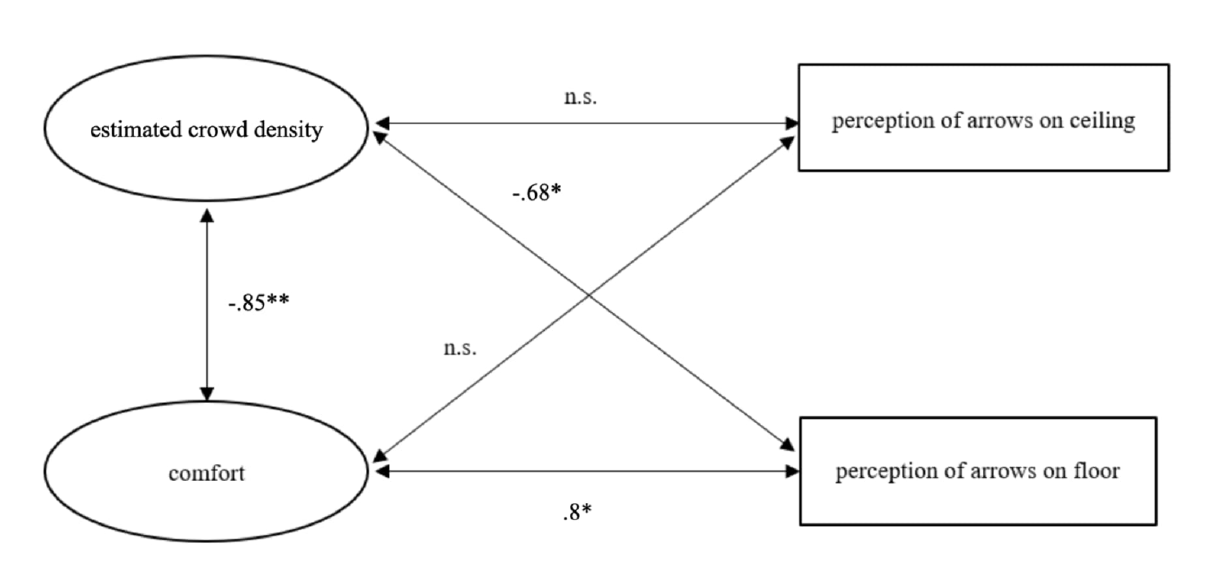
Figure 8. Illustration of correlations between estimated crowd density, comfort and number of gazes at arrows on the ceiling and floor,